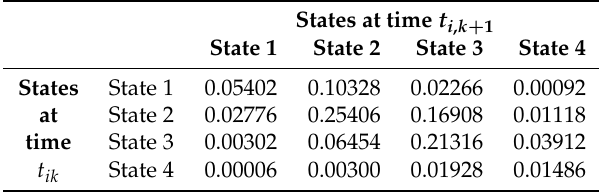
Table 1. Simulated data: rates of transitions between states.